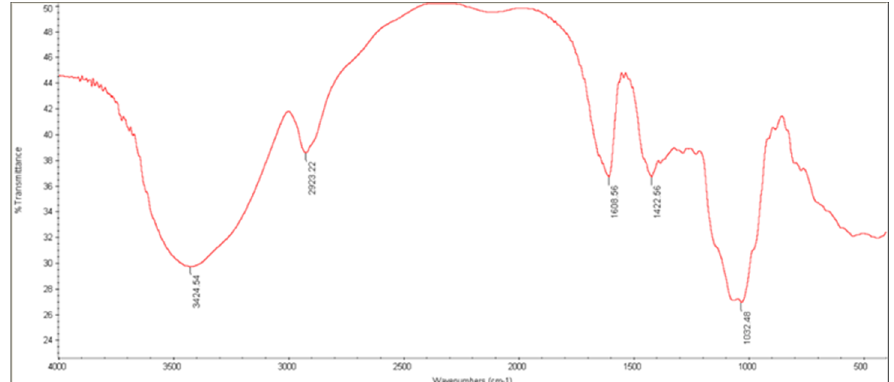
Agronomy 2022 , 11 , x FOR PEER REVIEW Figure 3. FTIR spectra of alginate. Figure 3. FTIR spectra of alginate.